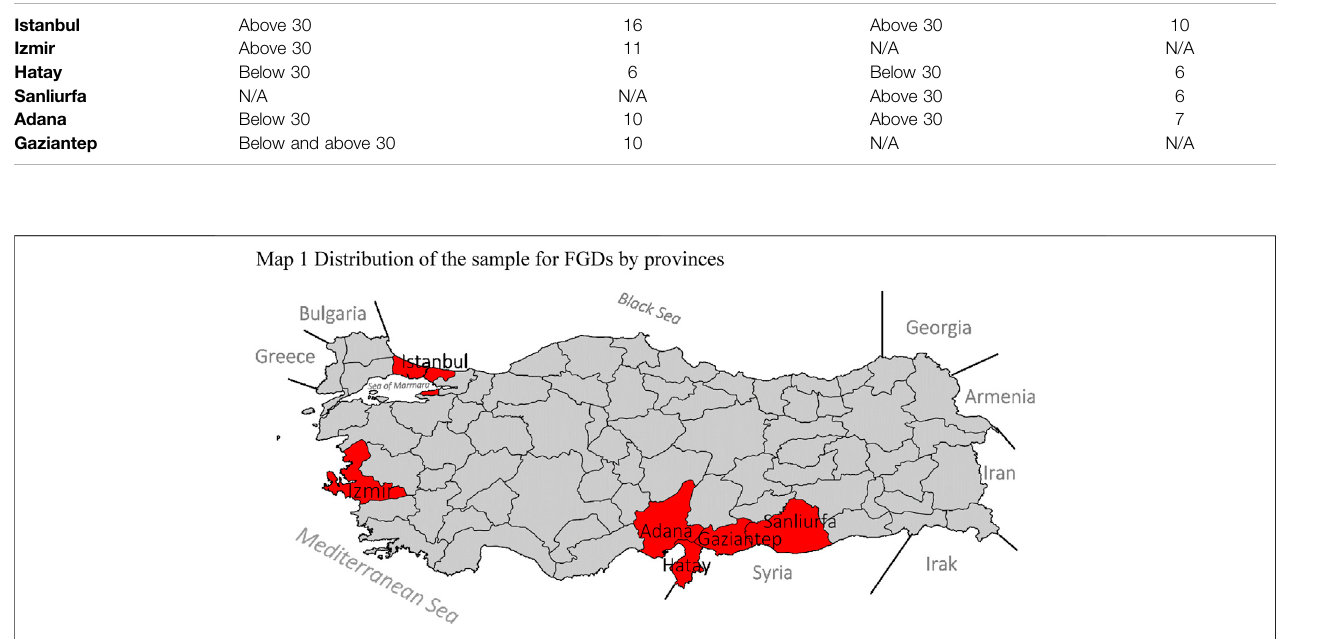
TABLE 1 | Sample by gender and age groups and the number of participants. Province